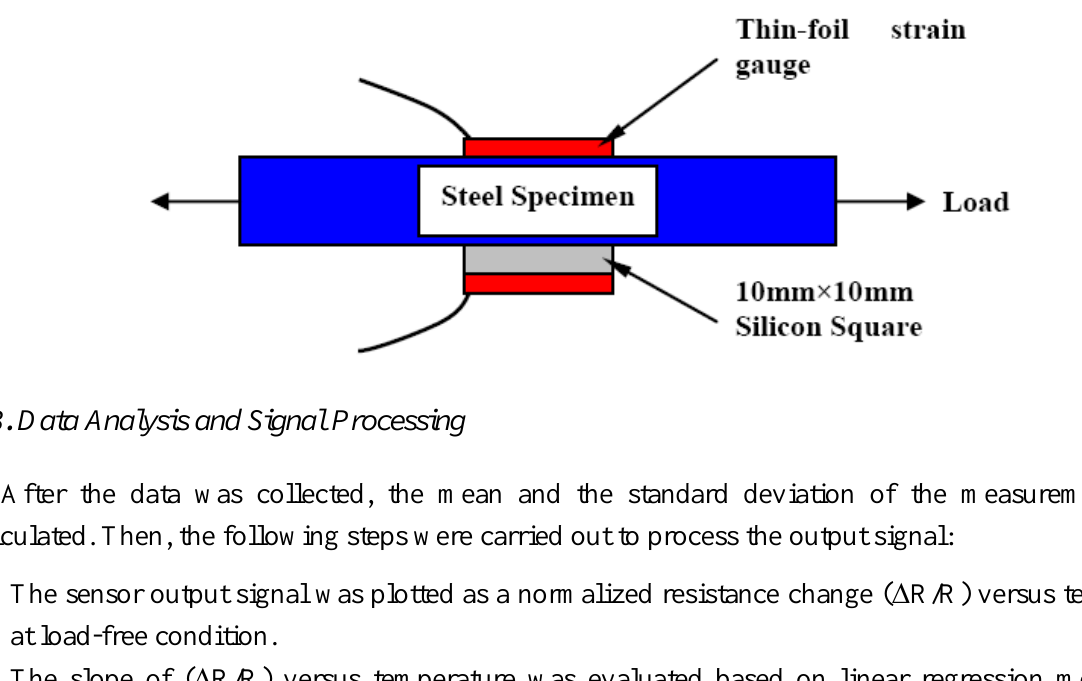
Figure 14. Schematic of the specimen to evaluate the relation between near-field strain and the far-field